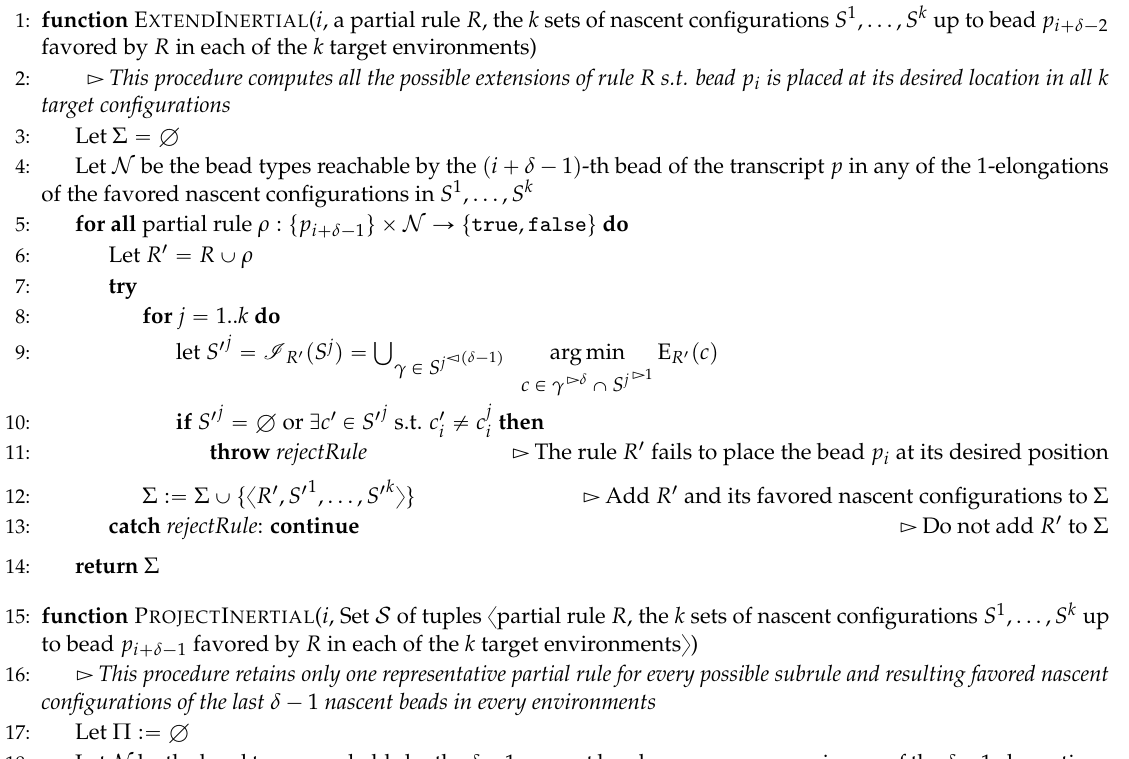
Algorithm 2 Rule Design Problem FPT Algorithm—Inertial